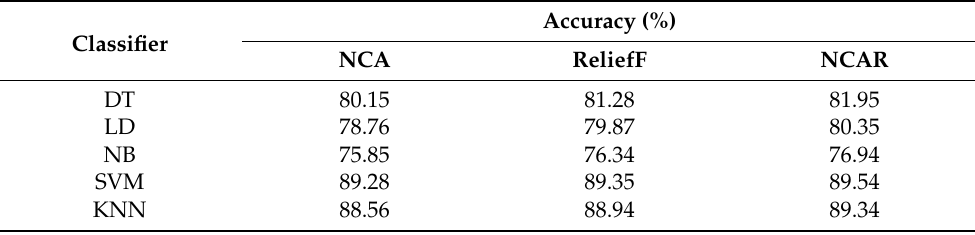
Table 1. The classifier performance results according to feature selection